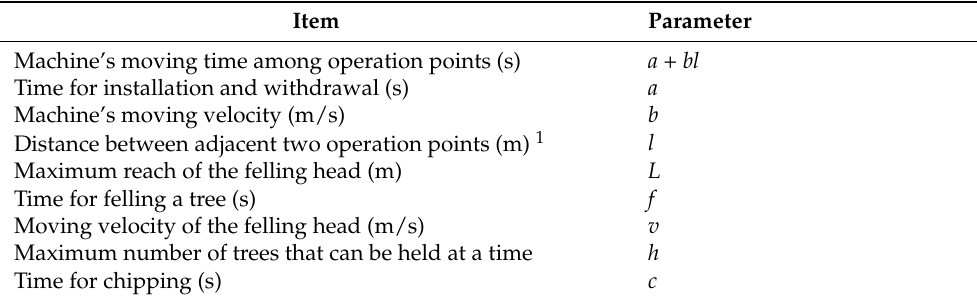
Figure 3. Flow chart of one cycle of harvesting operation. Table 1. Parameters of the simulation model for calculating the cycle time of the harvesting operation.